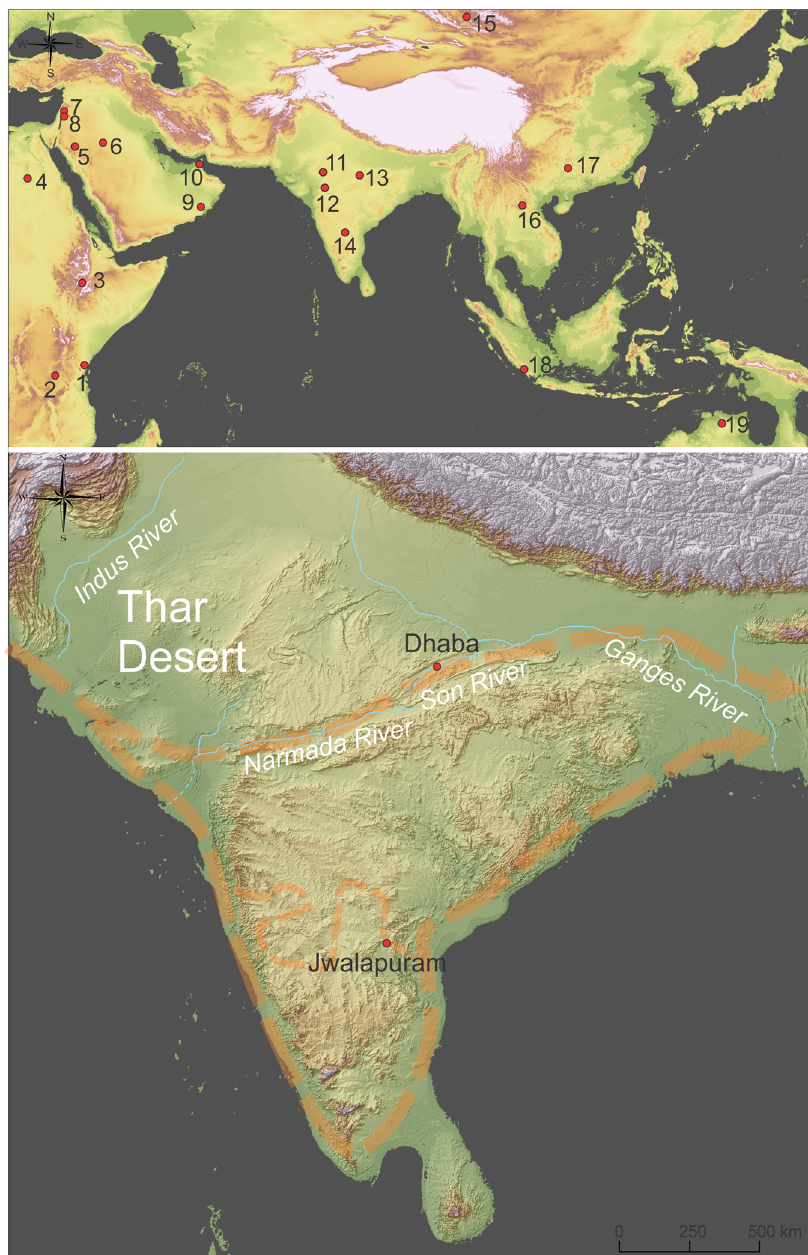
Fig. 1 Archaeological sites mentioned in the text overlaid on a digitial elevation model of the Eurasian and South Asian landmasses at − 60-m sea level consistent with MIS3/4. Topographic and bathymetric data was obtained from GEBCO 2014 Grid, version 20150318, http://www.gebco.net. Top: Archaeological sites associated with modern humans between Africa and Australia dated >50 ka. 1. Panga ya Saidi; 2. Mumba; 3. Porc Epic; 4. Nazlet Khater; 5. Al Wusta; 6. Jubbah; 7. Qafzeh; 8. Skhul; 9. Dhofar; 10. Jebel Faya; 11. Katoati; 12. Mehtakheri; 13. Dhaba; 14. Jwalapuram; 15. Denisova Cave; 16. Tam Pa Ling; 17. Fuyan Cave; 18. Lida Ajer; 19. Madjedbebe. Bottom: Location of key sites in India and modelled routes of dispersal (dashed orange lines and arrows) from west to east, after Field and colleagues 21